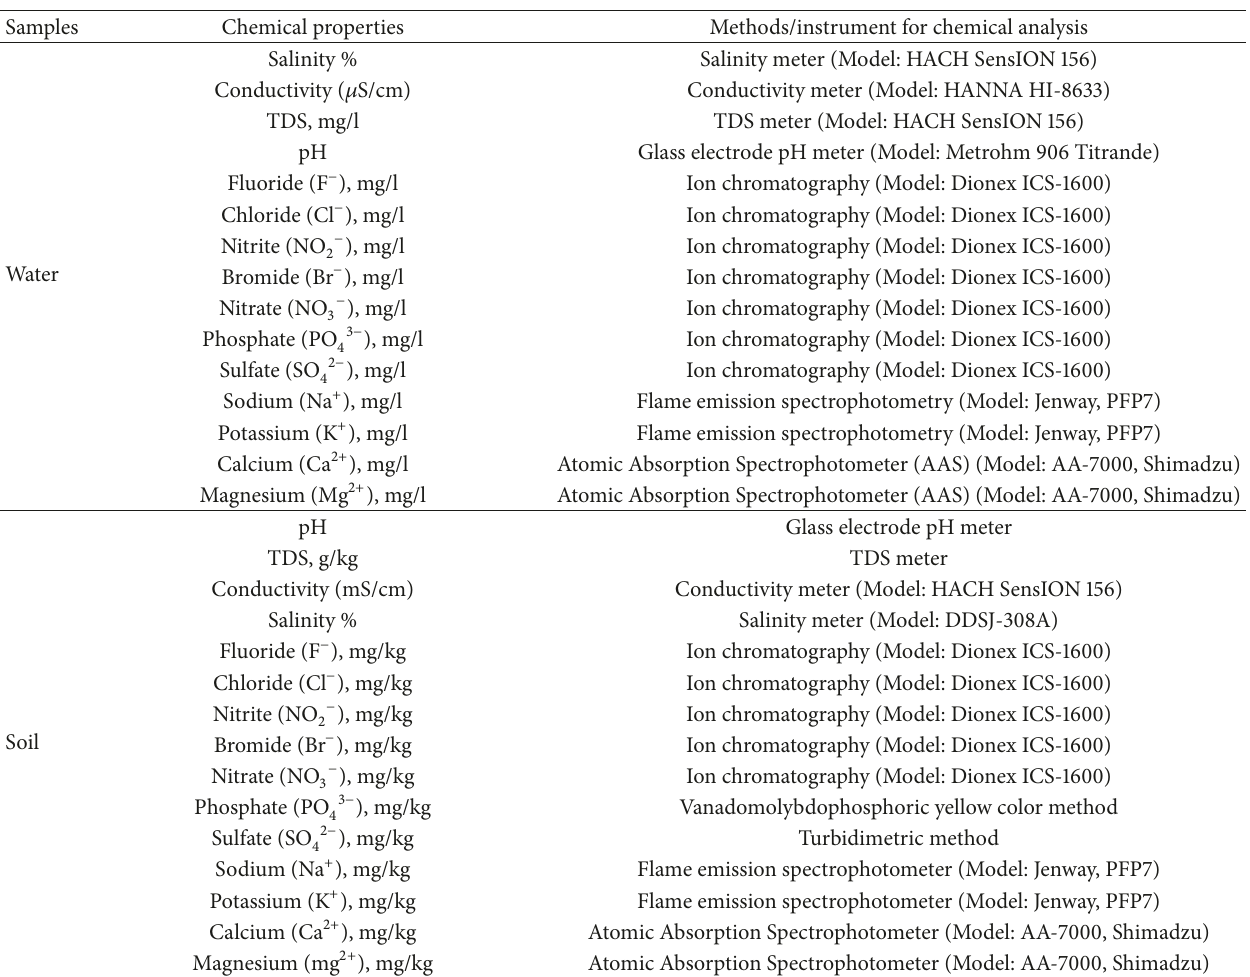
Table 2: Methods for the determination of salinity indicators in soil and water samples across the Kalapara coastal belt in Bangladesh.